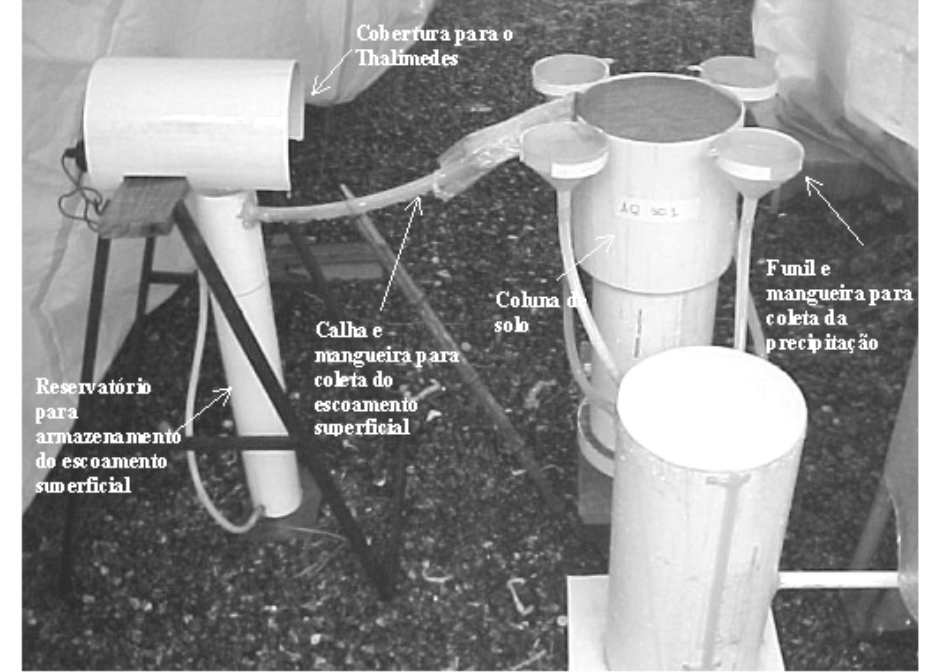
Figura 1. Estrutura construída para realização do